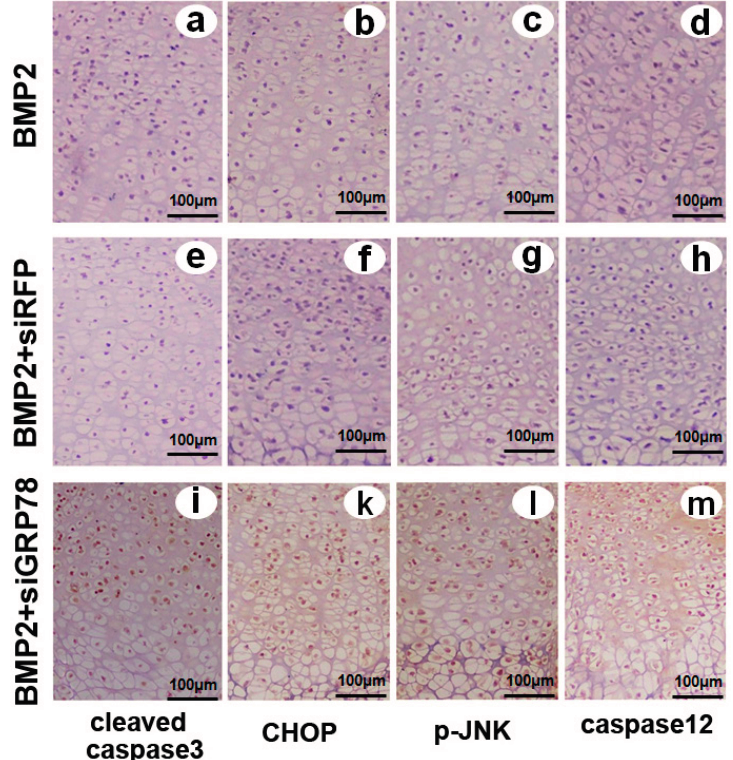
Figure 9. Expression of cleaved caspase3, CHOP, caspase12 and p-JNK in the growth plate chondrocytes in vivo . Metatarsals were explanted from 17-day-old mouse embryos and cultured in the presence of conditioned medium of BMP2 (300 ng/mL), BMP2 + siRFP, BMP2 + siGRP78 for 5 days. ( a ), ( e ) and ( i ) Immunohistochemistry staining was observed in low-power microphotograph of a section stained with anti-active caspase3 monoclonal antibody (brown) and counterstained with Mayer’s hematoxylin (blue); ( b ), ( f ) and ( k ) Immunohistochemistry staining was observed in a low-power microphotograph of a section stained with anti-CHOP monoclonal antibody (brown) and counterstained with Mayer’s hematoxylin (blue); ( c ), ( g ) and ( l ) Immunohistochemistry staining was observed in low-power microphotograph of a section stained with anti-p-JNK monoclonal antibody (brown) and counterstained with Mayer’s hematoxylin (blue); ( d ), ( h ) and ( m ) Immunohistochemistry staining was observed in low-power microphotograph of a section stained with anti-caspase12 monoclonal antibody (brown) and counterstained with Mayer’s hematoxylin (blue) and the scale bars represent 100 μ m. Taken together, these data demonstrate that GRP78 inhibits ER stress-mediated apoptosis in chondrocyte differentiation induced by